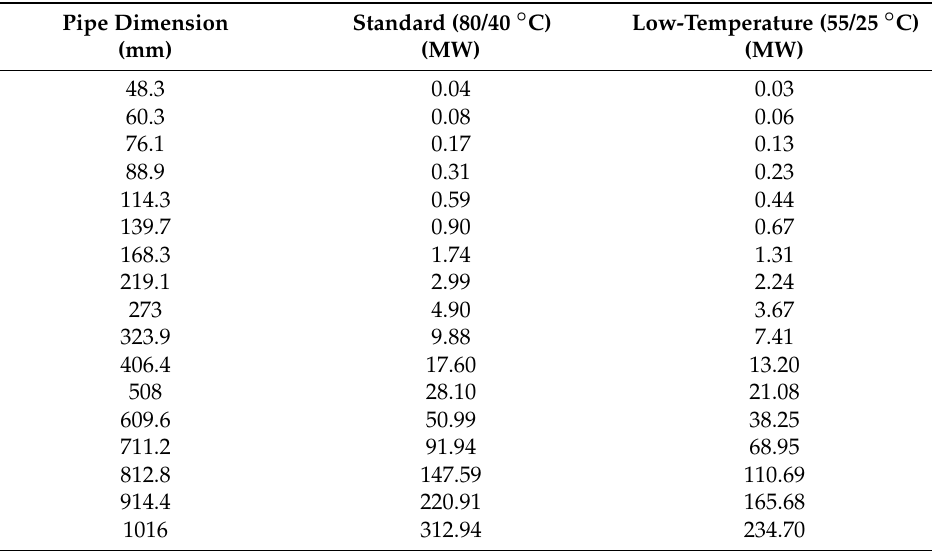
Table 3. Capacities of different pipe dimensions.